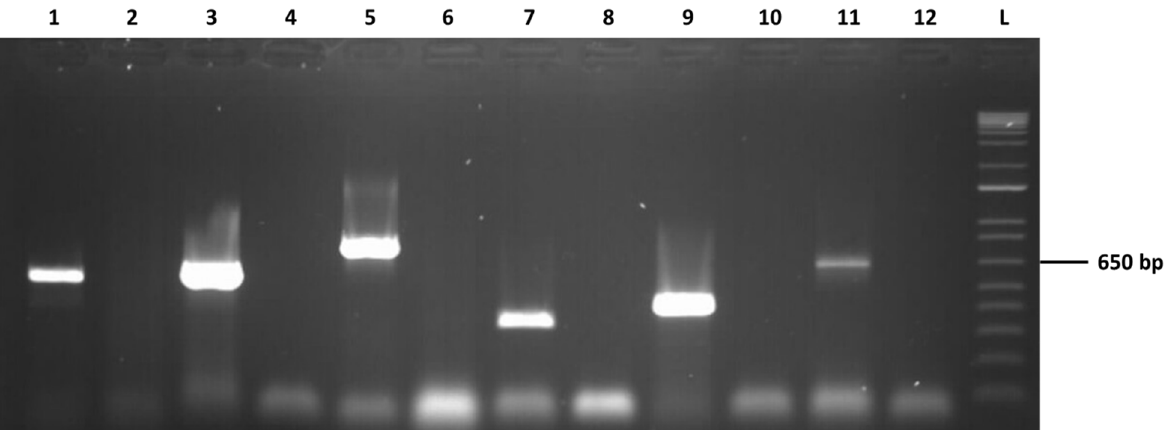
Figure 1. Confirmation of the presence of the six mycoviruses in Neofusicoccum parvum COLB by specific RT-PCRs. Primer pairs used are specific for NpMV3 (lanes 1 and 2), NpMV2 (lanes 3 and 4), NpEV1 (lanes 5 and 6), NpVV2 (lanes 7 and 8), NpNV3 (lanes 9 and 10), and NpVV1 (11 and 12). Templates are total nucleic acids from COLB (lanes 1, 3, 5, 7, 9, and 11) and water (lanes 2, 4, 6, 8, 10, and 12). A molecular marker is in lane 13.